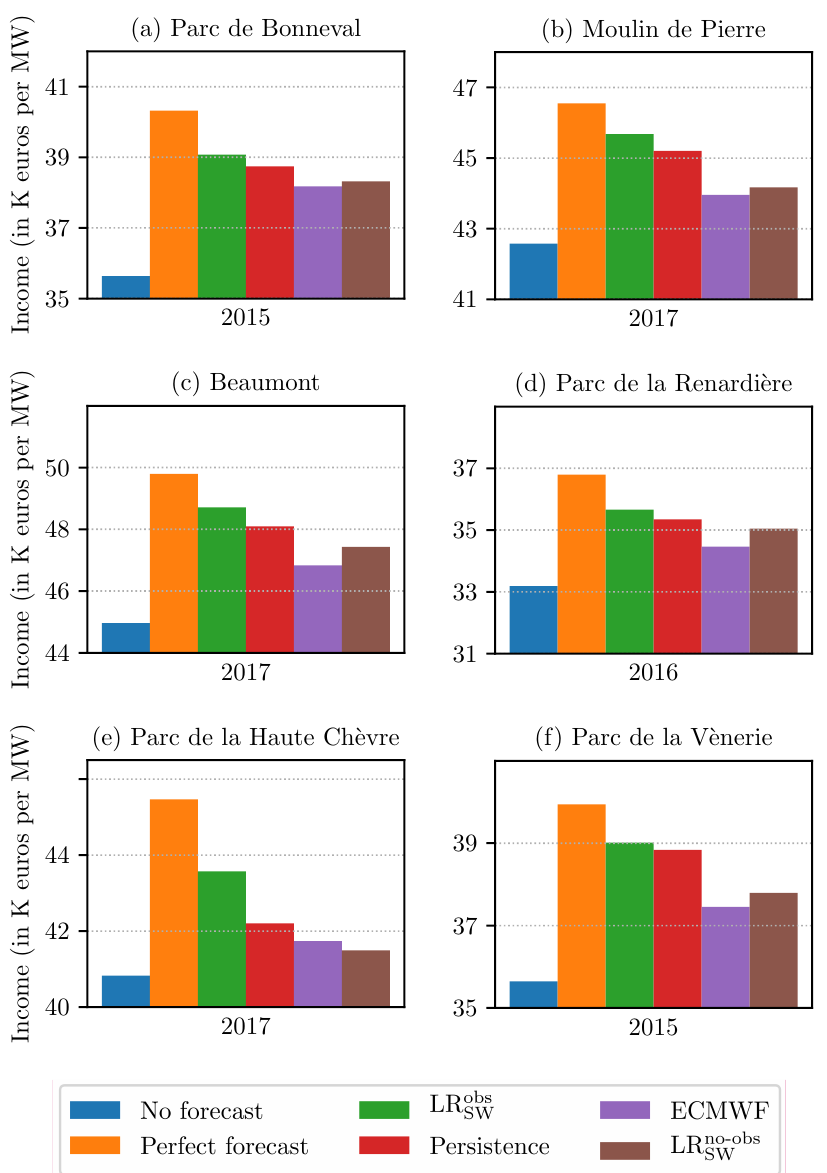
Figure 11. Same as Figure 10 for the six wind farms. Subfigure ( a ) shows the results for Parc de Bonneval, ( b ) for Moulin de Pierre, ( c ) for Beaumont, ( d ) for Parc de la Renardière, ( e ) for Parc de la Haute Chèvre and subfigure ( f ) shows the results for Parc de la Vènerie. A few changes in the methodology must be noted. (1) for day-ahead bids we use the ECMWF forecasts from 12 h ahead to 24 h ahead and for the last twelve hours, we use the last available lead time from ECMWF. (2) for intraday bids, we use the last price, available on EpexSPOT website, without distinction between purchase price and selling